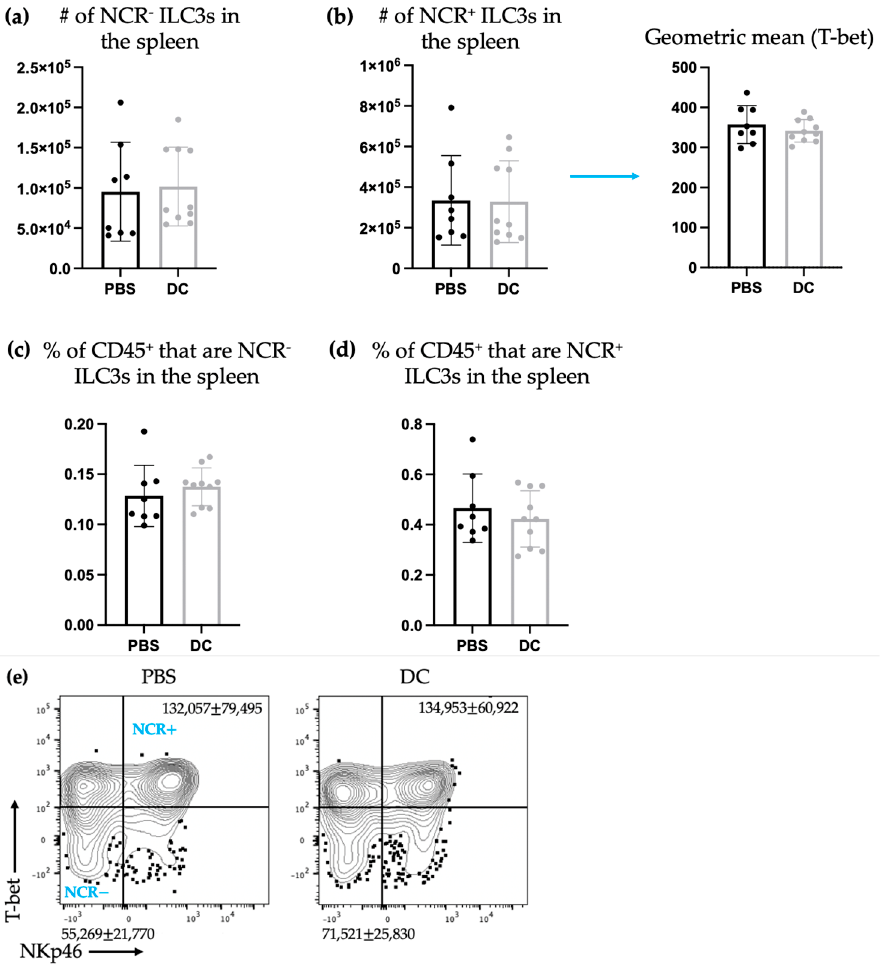
Figure 2. There were no changes in the number of splenic ILC3s after DC immunization. Female C57BL/6 mice ( n = 8 [PBS] or 10 [DC]) were inoculated with DC vaccines via hind footpad injections. Spleens were harvested one week following inoculation and examined for ILC3 populations. Splenic total number of ( a ) NCR − ILC3s and ( b ) NCR + ILC3s (and the geometric mean fluorescent intensity of T-bet for NCR + ILC3s) and the percentage of splenic CD45 + cells that were ( c ) NCR − ILC3s and ( d ) NCR + ILC3s were monitored and quantified by flow cytometry analysis. A Student’s t-test was used to determine significance between the populations in the control mice inoculated with phosphate-buffered saline (PBS) and the DC-inoculated mice. The means were not significantly different. Representative dot plots showing the average number of splenic ( e ) NCR − ILC3s and NCR + ILC3s. The standard deviation and mean are represented by the graph bars and error bars. Since ILC3 cytokine profiles can be influenced by environmental factors, ILC3 produc- tion of IL-22 and IL-17 in the spleen was measured one week following DC vaccination. There was an increase in ILC3s producing IL-17 or IL-22 or both cytokines in mice